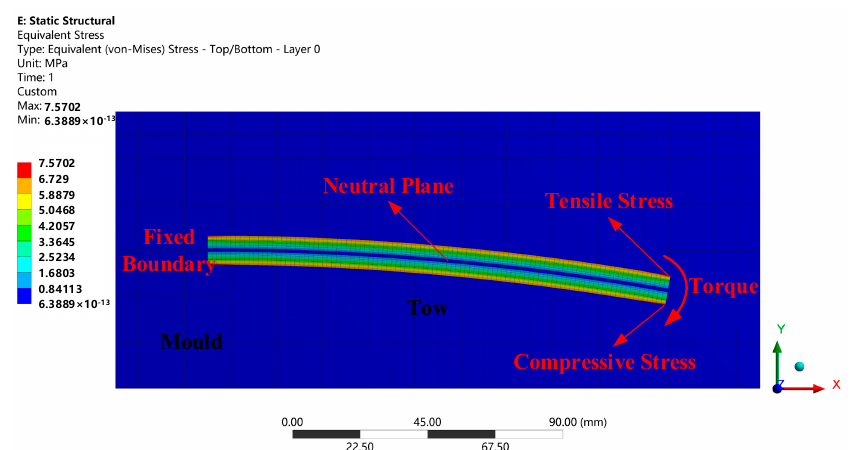
Figure 9. Simulation results of tangential stress.